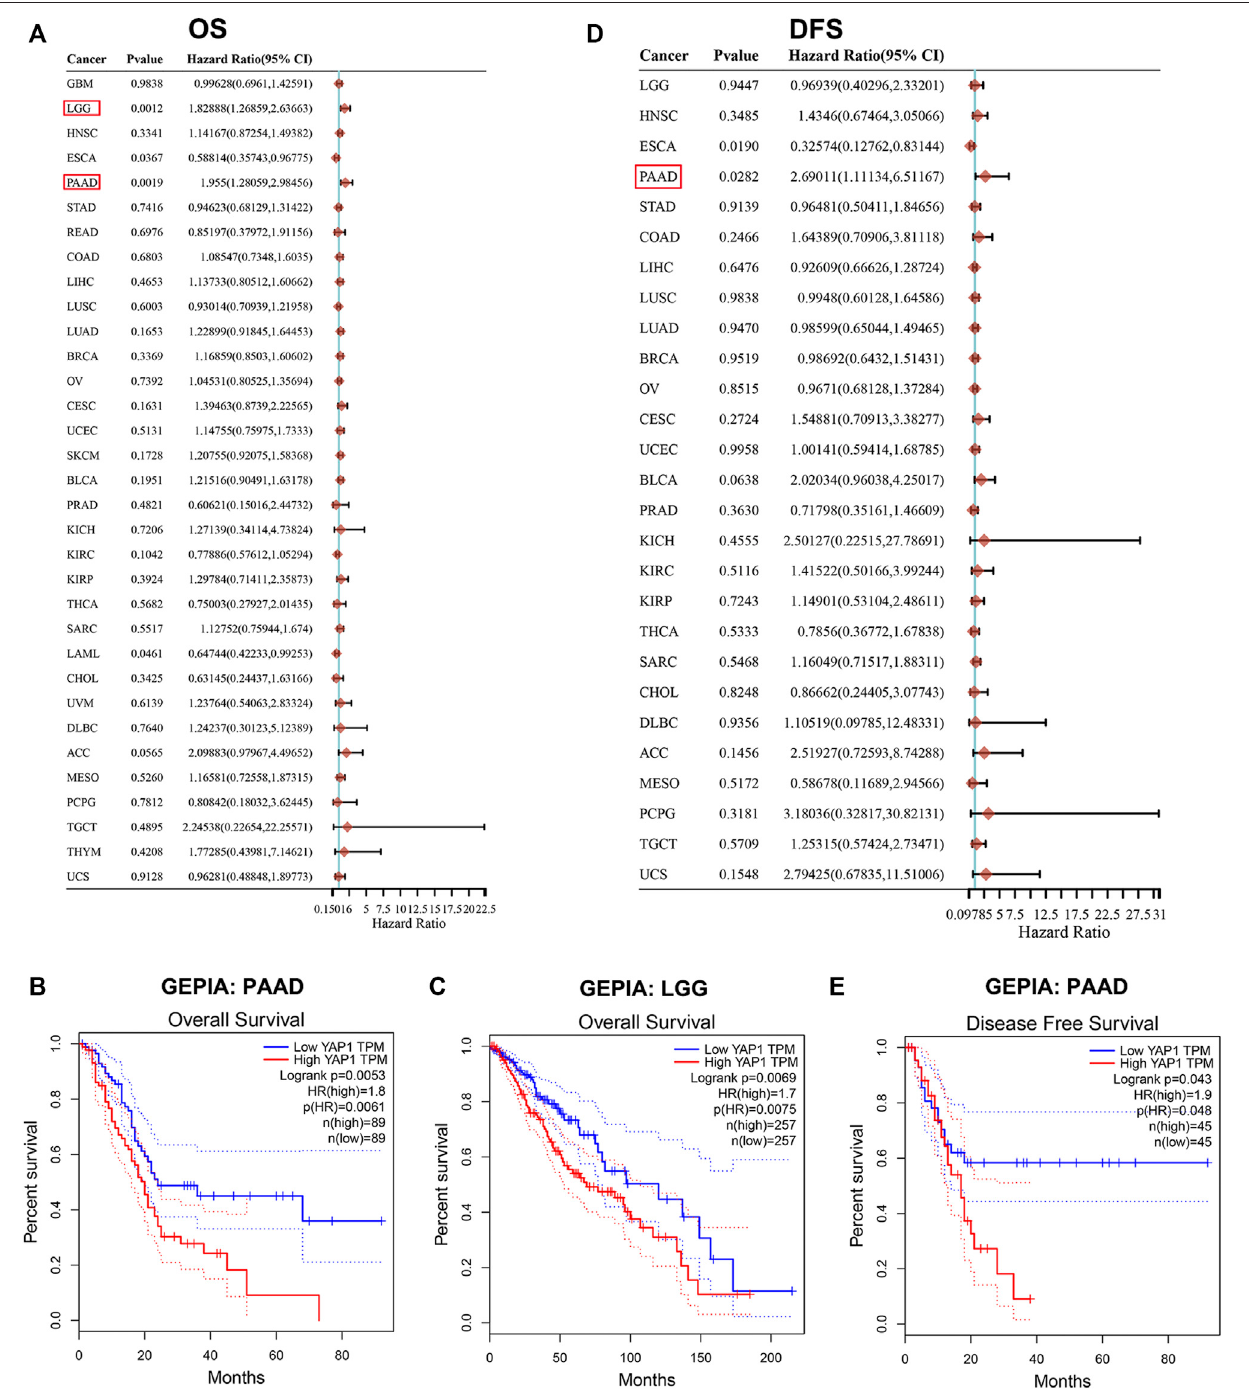
FIGURE2| Prognosis valueof YAP1 inTCGA pan-cancer. (A) Forrestplotsofresultsfrom theunivariatesurvivalanalysisinpan-cancer forOS.Diamondsindicate the hazard ratios (HRs) from the univariate overall-survival analysis, and HR < 1 represents a favorable factor, while HR > 1 represents an adverse factor. The 95% con fi dence interval (95% CI) is shown asthe horizontalline across the diamond. (B-C) Kaplan-Meier OS analysis of YAP1 in PAAD and LGG by GEPIA. (D) Forrest plots of results from the univariate survival analysis in pan-cancer for DFS. (E) Kaplan-Meier DFS analysis of YAP1 in PAAD by GEPIA.